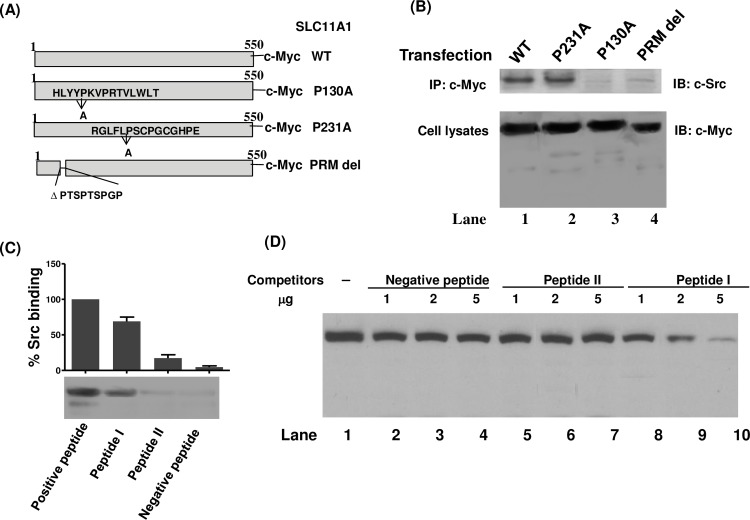
The proline-rich motif of SLC11A1 is required for association with c-Src kinase.(A) Schematic representation of the P130A, P231A and PRM-deletion constructs of SLC11A1. (B) U937 cells were transfected with constructed pCB6 vectors expressing c-Myc-tagged wild-type SLC11A1, P231A, P130A or PRM-deletion mutant together with c-Src expression vector. Transfected cells were treated with PMA for 48 hrs and cell lysates were immunoprecipitated with anti-c-Myc antibody (9E10). The bound proteins were probed with a rabbit polyclonal antibody against c-Src. Expression of c-Myc-tagged wild-type SLC11A1, P231A, P130A or PRM-deletion mutant in transfected cells were also detected by Western blot analysis. (C) In vitro binding of c-Src to the PXXP motifs of SLC11A1. The SLC11A1 PRM peptide I (GEVCHLYYPKVPRTVLWLTI), PRM peptide II (ISSPTSPTSPGPRQAPPRE T), the negative control peptide (IPDTKPGTFSLRK LWAFTGPGFLM) and the positive control peptide (Src substrate Sam68), which were described in Materials and Methods, were coupled to activated CH-Sepharose 4B. Binding of these peptides to purified c-Src was detected by immunoblotting with anti-Src antibody. A representative Western blot is shown. (D) Peptide competition binding assay was performed. Purified c-Src was added 1, 2 or 5 μg of negative peptide, peptide I or peptide II before incubating with the CH-Sepharose 4B coupled with the positive control peptide. The illustrated showing the inhibitory effects of different peptides on c-Src binding to the positive peptide.